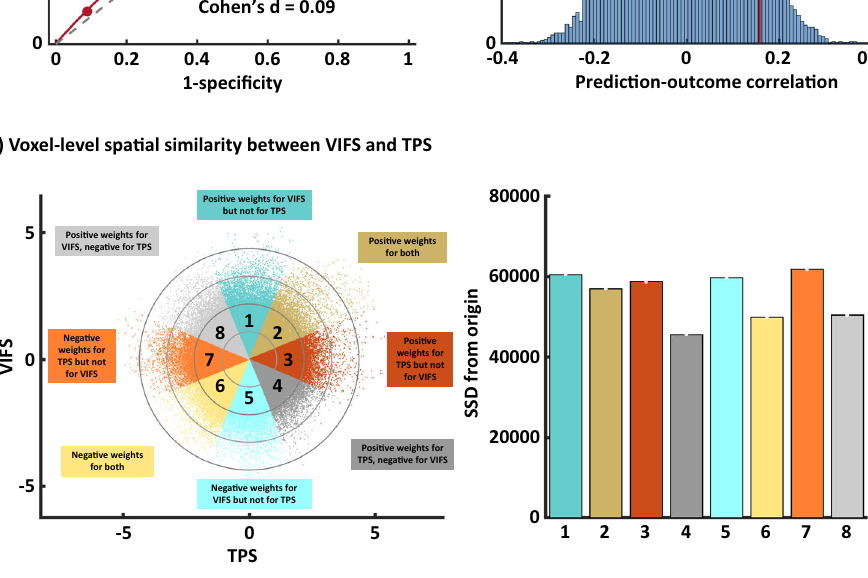
Fig. 5 Comparing fear- and threat-predictive signatures. a depicts that visually induced fear signature (VIFS) does not distinguish unreinforced CS + versus CS − . b shows the histograms of prediction of threat-predictive signature (TPS) on fear data from nonparametric permutation test. Histograms show the distribution of null-hypothesis prediction-outcome correlations, and the red line shows the actual correlation coef fi cient. c demonstrates the scatter plot displaying normalized voxel weights for VIFS ( y axis) and TPS ( x axis). Bars on the right represent the sum of squared distances from the origin (0,0) for each Octant. Different colors are assigned to the eight Octants that re fl ect voxels of shared positive or shared negative weights (Octants 2 and 6, respectively), selectively positive weights for the VIFS (Octant 1) or for TPS (Octant 3), selectively negative weights for the VIFS (Octant 5) or TPS (Octant 7), and voxels with opposite weights for the two neural signatures (Octants 4 and 8). Source data are provided as a Source Data fi